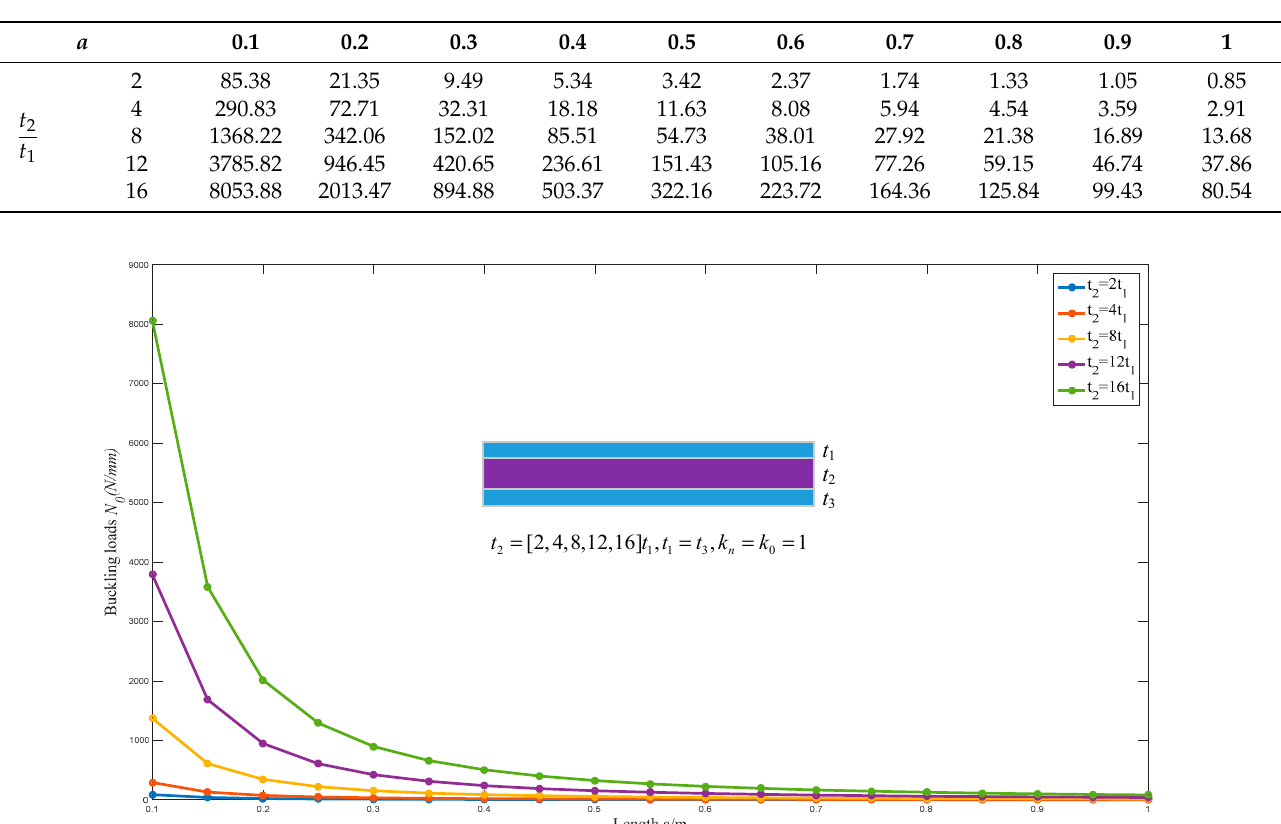
Figure 9. Buckling loads affected by the thickness ratio of the core layer. 4.5. Critical Buckling Load Affected by the Honeycomb Reinforcement’s Thickness The composite structure’s dynamic equivalent effective stiffness is directly affected by the honeycomb reinforcement’s width. By increasing the reinforcement’s width, the dynamic equivalent effective stiffness of the composite structure is increased, and further- more, the structure’s buckling loads in the considered research are significantly influ- enced. In the present analysis, to illustrate the trend of the buckling load affected by the 2